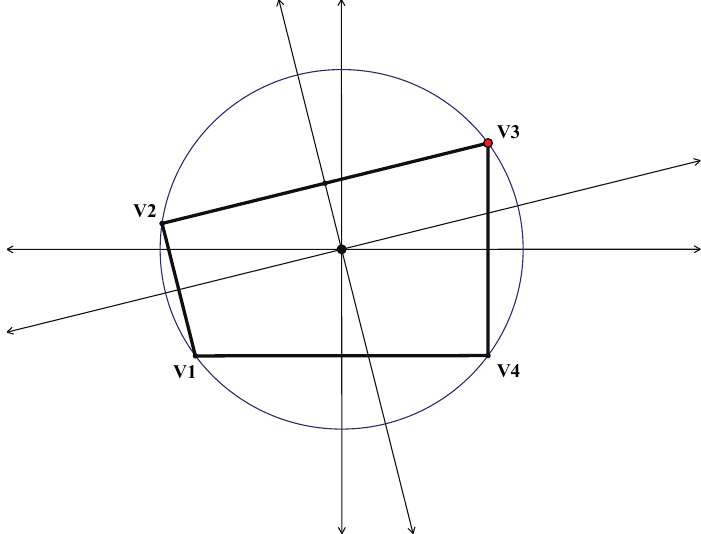
Figure 9 : Circle now passes through all the vertices of the